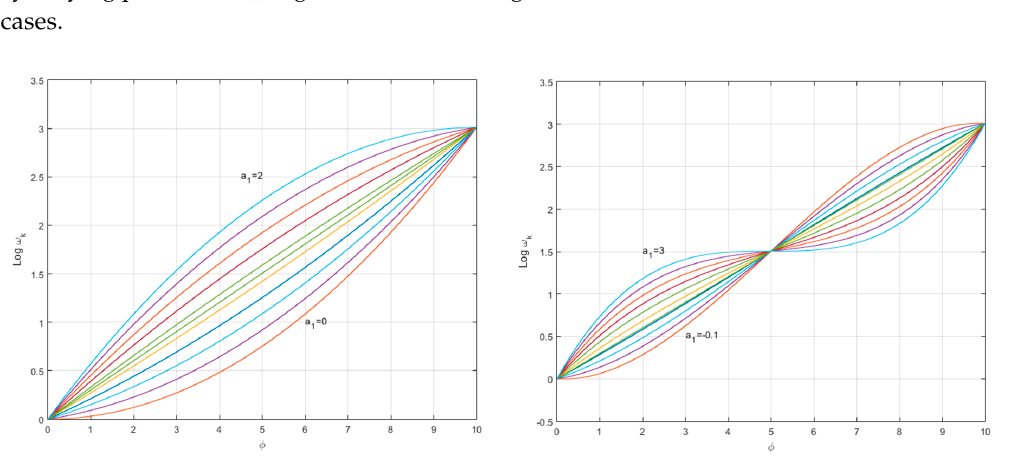
Figure 7. Two examples of pole distributions with D 3 : M = 2 ( left ), M = 3 ( right ).